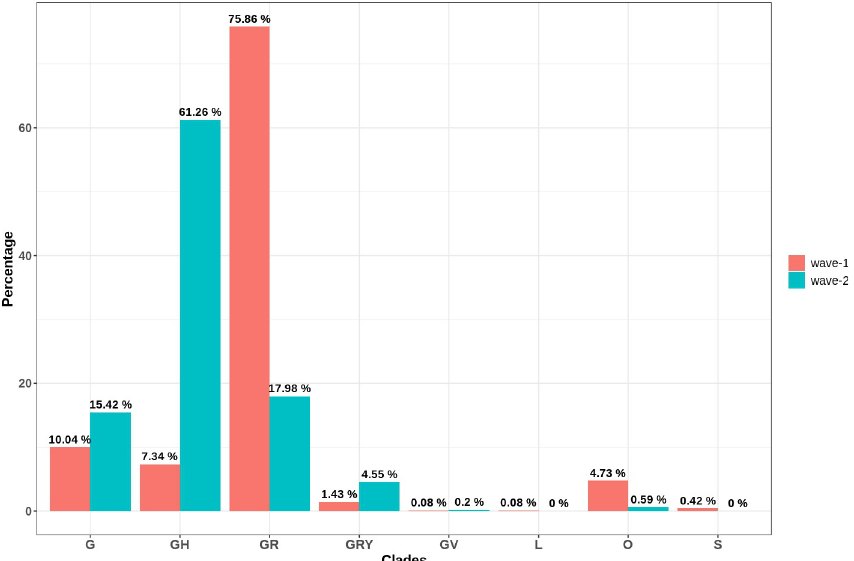
Fig 7. Comparative distribution of different clades in two waves of COVID-19 pandemic in Bangladesh. G clade and its descendants dominated throughout the pandemic. But GR clade in the case of wave-1 and GH clade in the case of wave-2 were the most prevalent ones. In the second wave, the L, O, and S clades were almost completely lost.